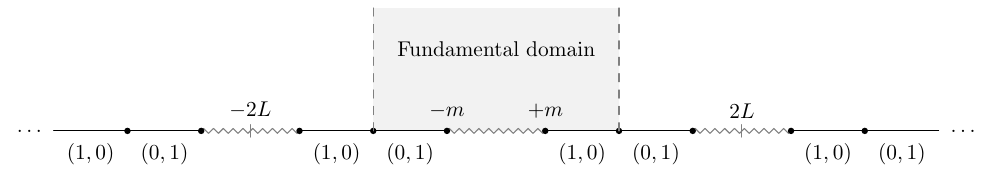
Figure 5 . Rod structure for Example